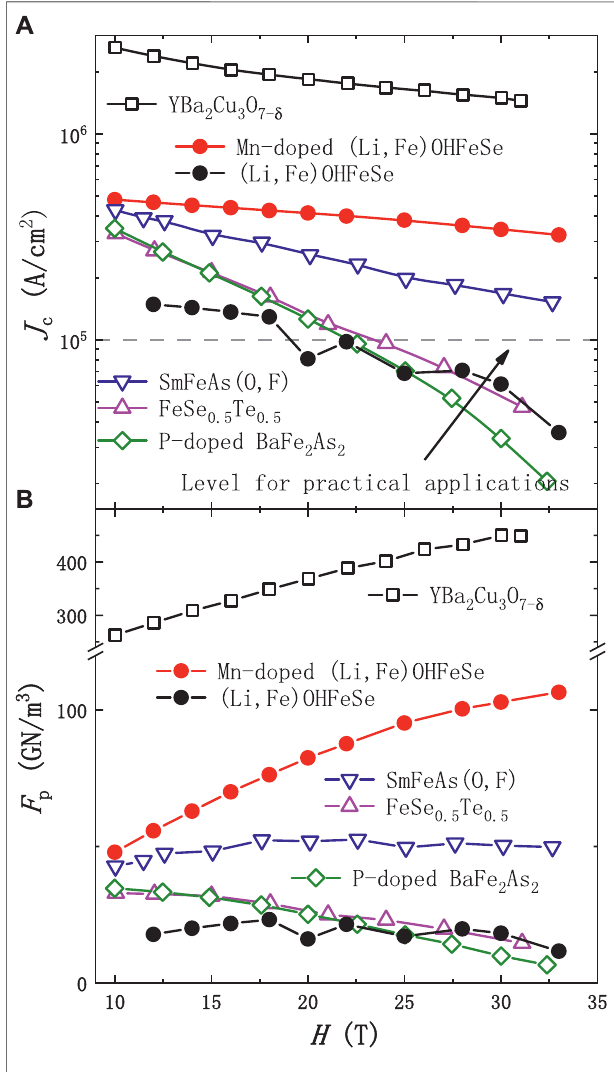
FIGURE 12 | Magnetic fi eld dependence of J c (A) and F p (B) of several superconductors [17], including Mn-doped and pure (Li,Fe)OHFeSe fi lms at 5 K, SmFeAs(O,F) fi lms [95], FeSe 0.5 Te 0.5 fi lms [96], P-doped BaFe 2 As 2 fi lms [97], and YBa 2 Cu 3 O 7 − δ wires [98] at 4.2 K under c-axis fi